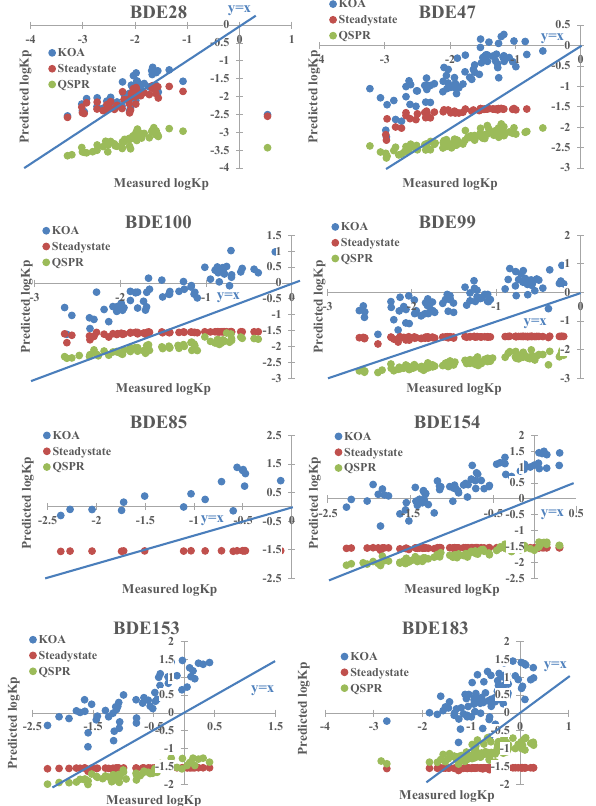
Figure 2. Comparison of measured and predicted log K p of individ- ual PBDEs. The blue lines represent the 1:1 line. No data from the QSPR model were available for BDE85.